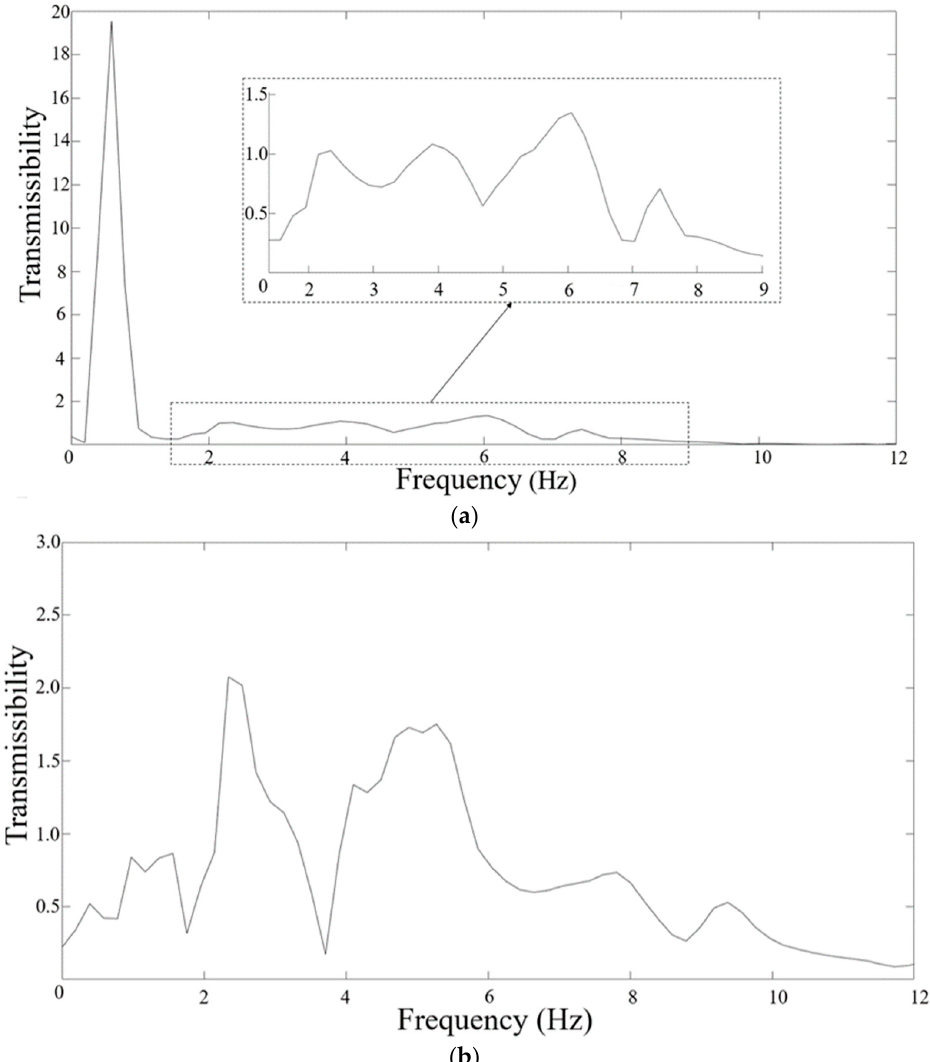
Figure 18. Seatback (X-axis)/Floor (Z-axis) transmissibility: ( a ) comfort seat; ( b ) standard seat.